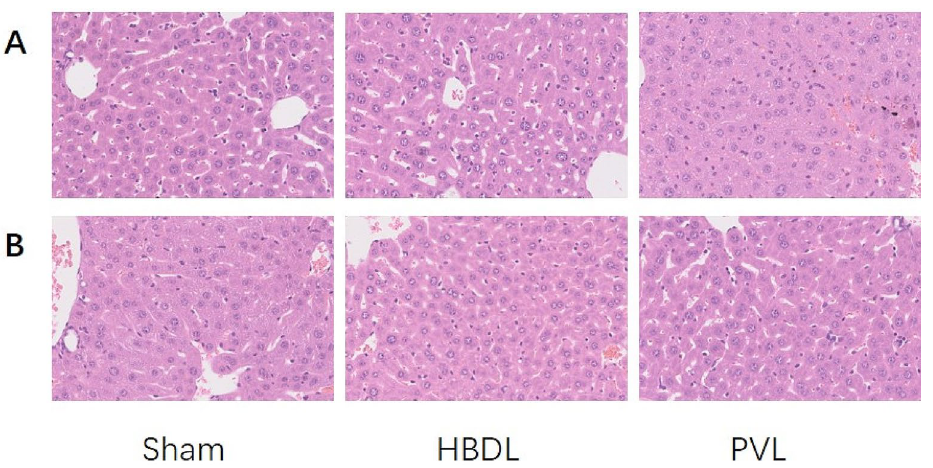
Figure 8. Observe the general liver histological changes caused by hilar biliary ligation or portal vein ligation by HE staining. The first day after operation ( A ); the first week after operation ( B ). (×